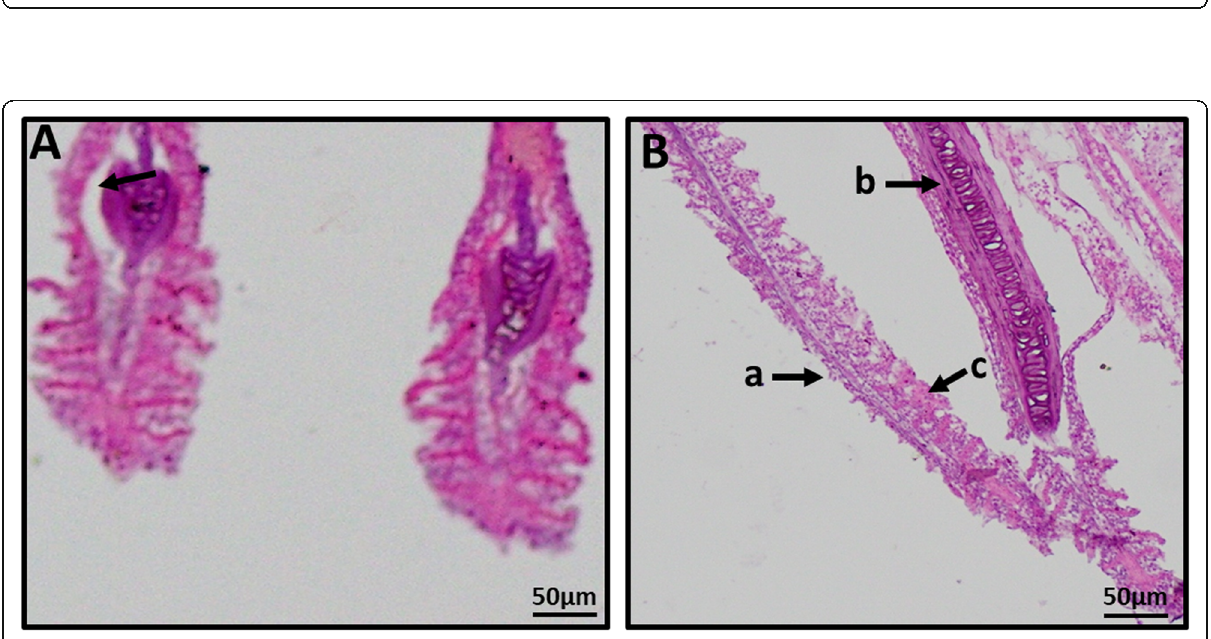
Fig. 4 Photomicrographs of the kidney of Heteropneustes fossilis after 7-day exposure to 0.015 ppm Envoy 50 SC. a Control — normal regular and systematic arrangement of kidney tubules and hematopoietic cells were found; b glomerular expansion (a) and increasing the diameter of renal tubule (b); C necrosis (a) and pyknosis (b); and d vacuolation (a) and hemorrhage (b) were